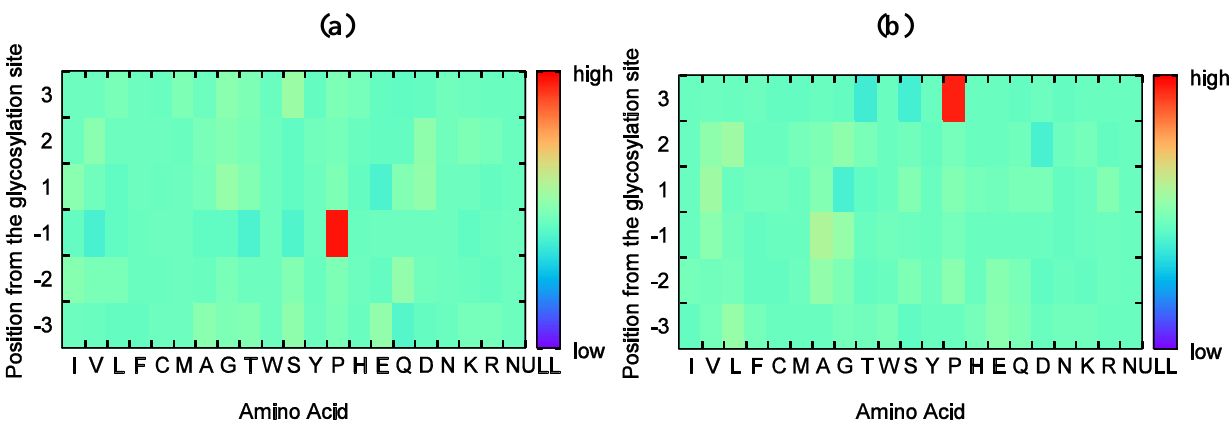
Figure 4. Independent components of the amino acid sequence around the isolated glycosylation sites, corresponding to the high existence probability of ( a ) Pro at −1, and ( b ) Pro at +3. The horizontal axis indicates 20 amino acids and a null, and the vertical axis indicates the relative position to a glycosylation site and ranges from −3 to +3. The gradation of each box shows the existence ratio of each amino acid at each